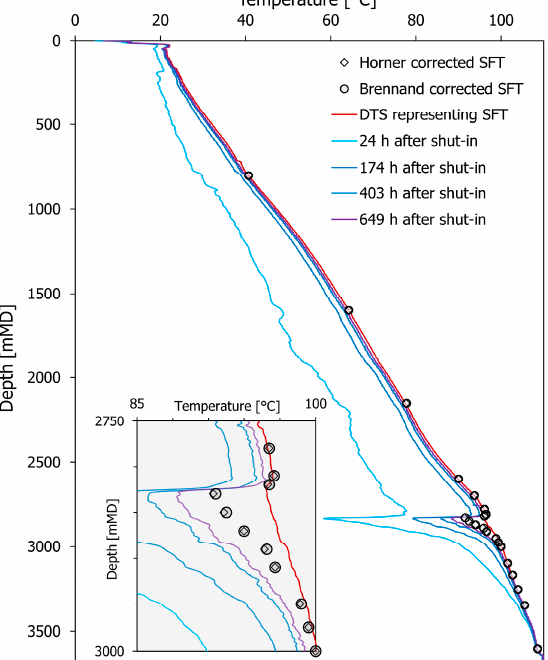
Figure 8. DTS profiles measured before (red line) and after (blue lines) a cold-water injection test at the well SLS TH4. The grey box shows the profiles at the top interval of the reservoir section. Point data are Horner-corrected (diamonds) and Brennand-corrected (circles) temperatures from temperatures read from the blue DTS